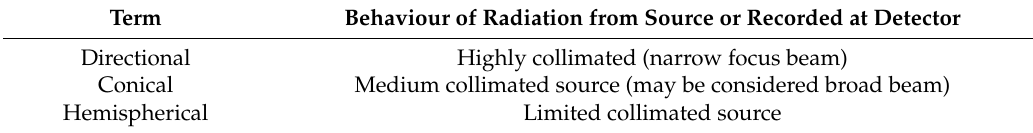
Table 1. Definitions of descriptors of reflectance as provided by Hapke